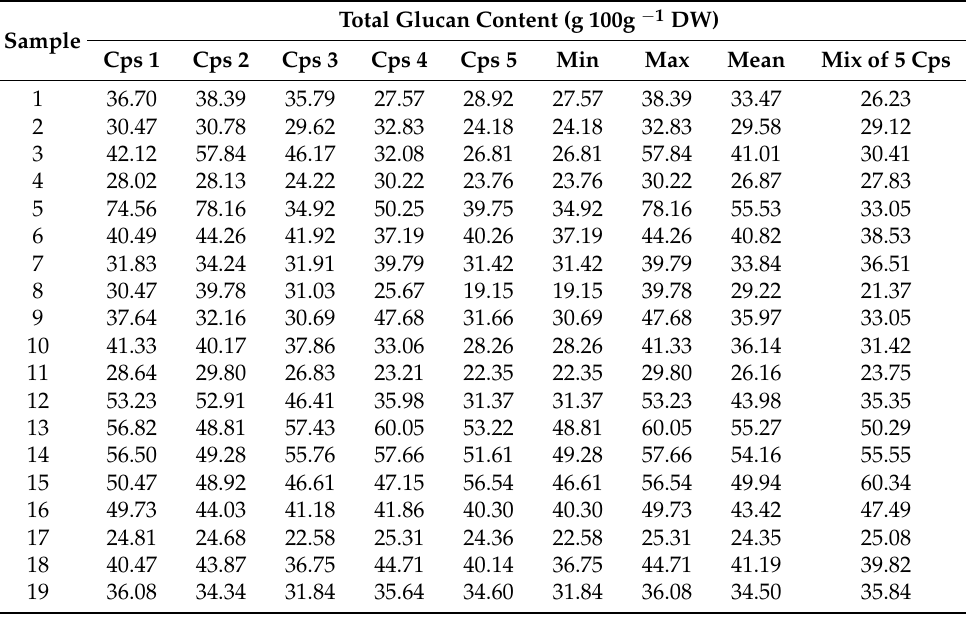
Table 9. Total glucan content determined in 19 mushroom-based supplements in single capsule (Cps 1 to 5) and on the mixture derived from 5 capsules (Mix of 5 cps) and expressed in g 100 g − 1 DW. Sample